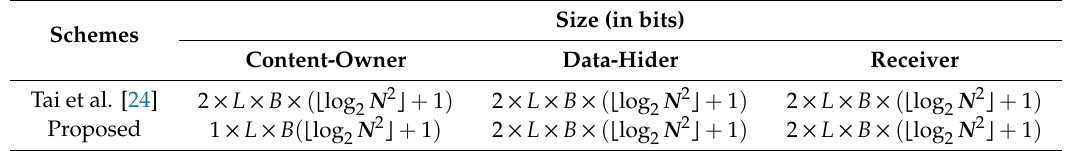
Table 4. Comparative analysis of our scheme in terms of bit-size for image ( L × B) with Tai et al. [24].